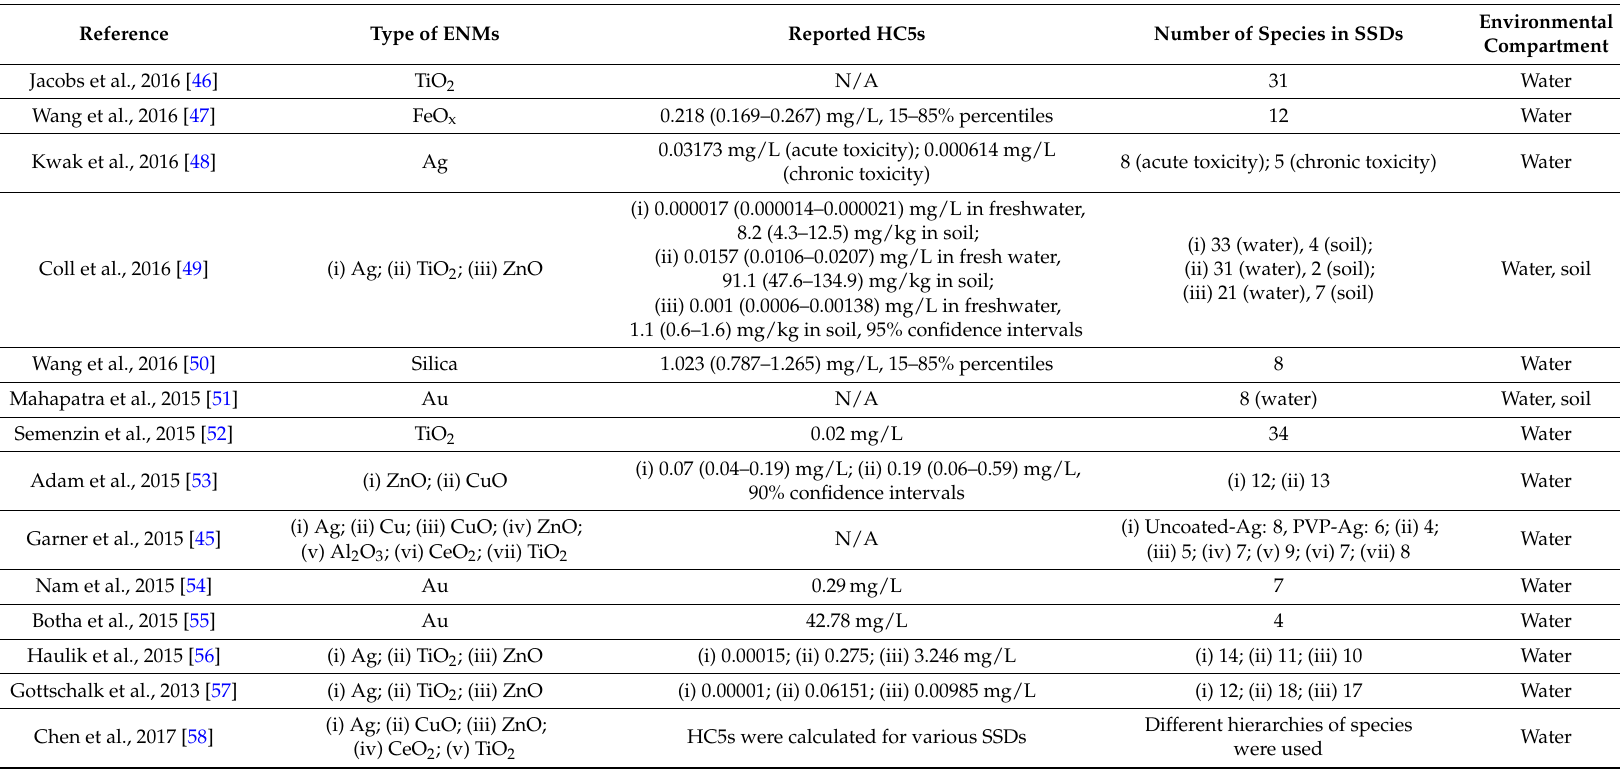
Table 2. Summary of the state-of-the-art of the developed SSDs for metal and metal oxide ENMs. N/A indicates that relevant information is not